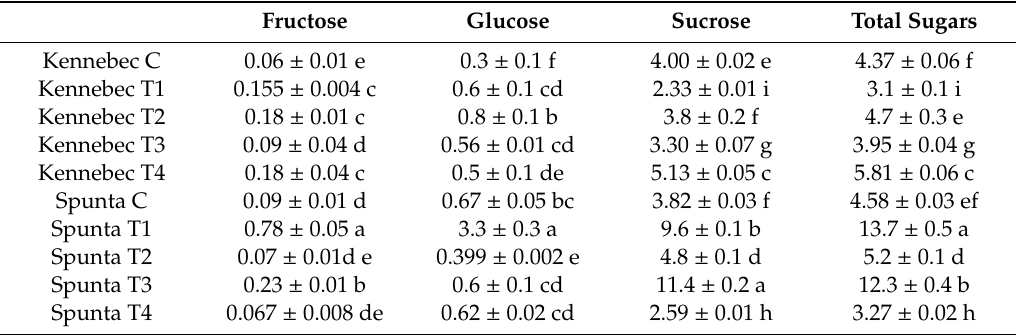
Table 4. Composition in sugars (g / kg fw) of the studied potato varieties in relation to the fertilization regime (mean ±